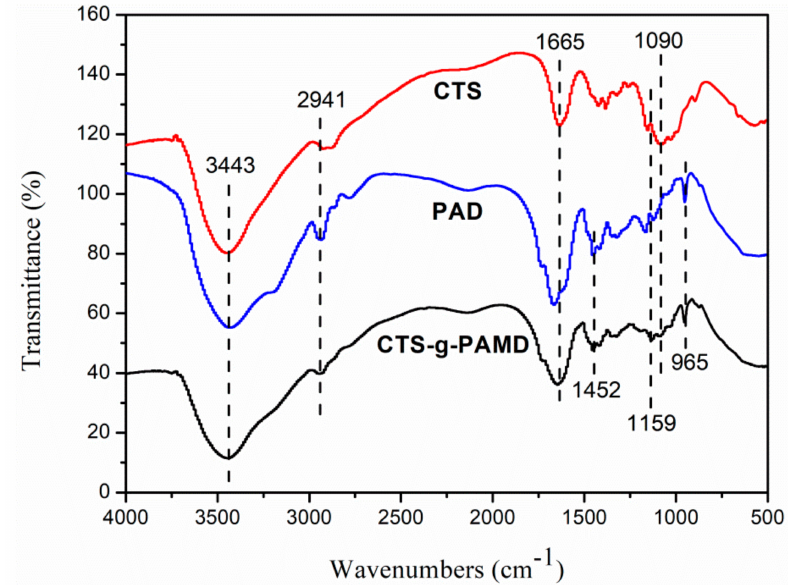
Figure 3. The Fourier-transform infrared spectra (FT-IR) of the polymers (AM, DMC and